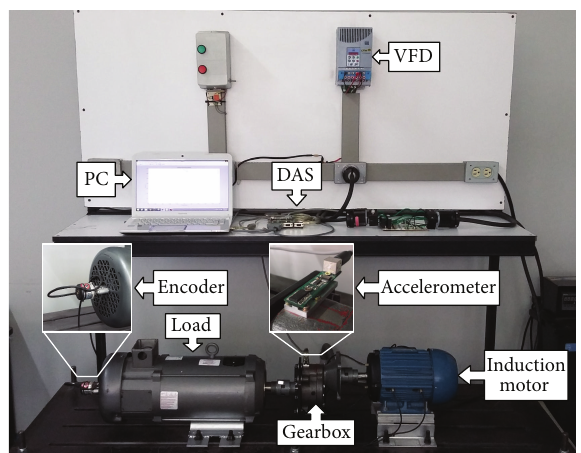
Figure 4: Electromechanical test bench used for experimental validation of the